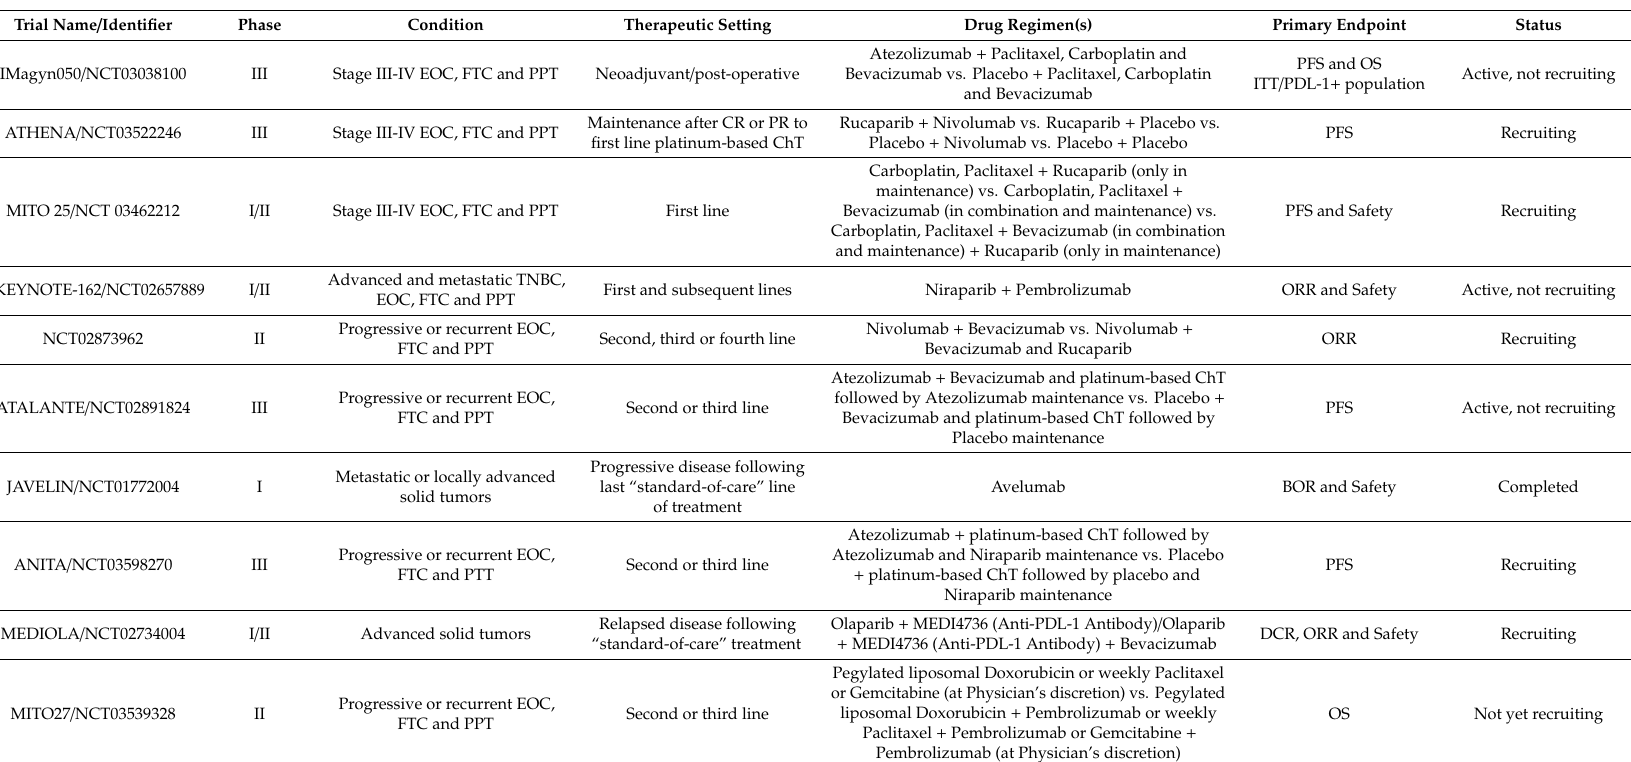
Table 2. Main clinical trials with immune checkpoint inhibitors in epithelial ovarian